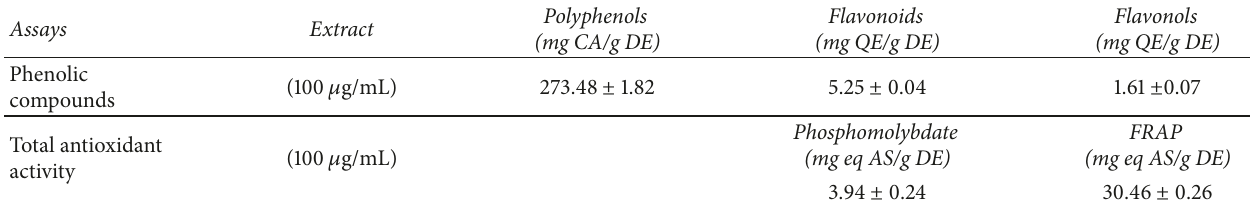
Table 1: Phenolic composition and antioxidant power of the water-ethanol extract of Tetrapleura tetraptera. Assays Phenolic compounds Total antioxidant activity